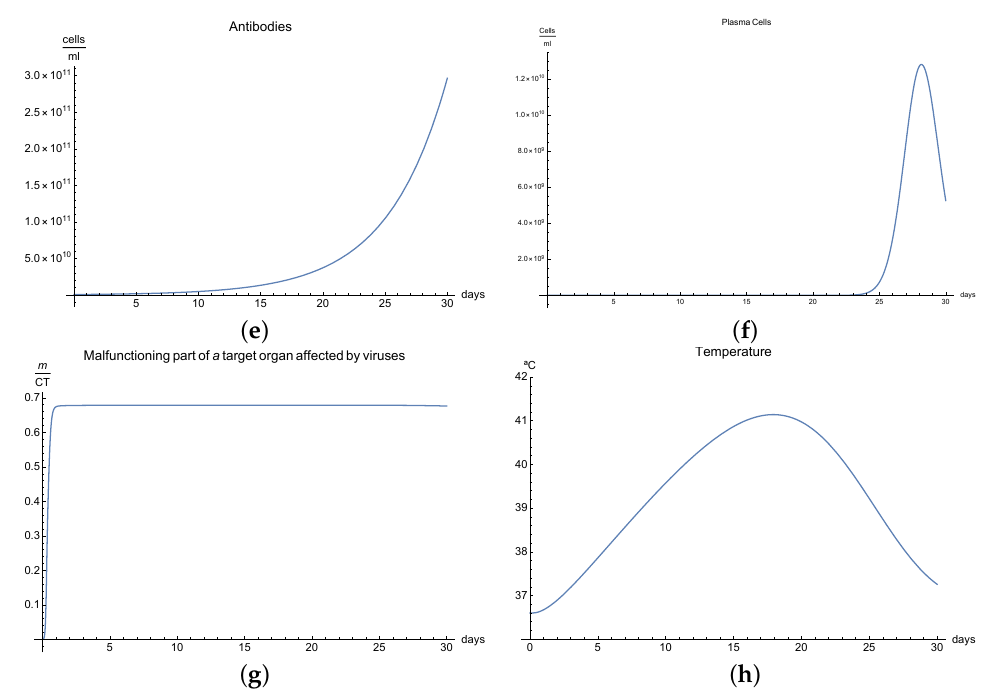
Figure 2. Numerical results of the mathematical model for the case with the immunophysiological response of COVID-19 infection in its “immunodeficient” form: ( a ) the viral load V ( t ) , ( b ) the cytotoxic T-lymphocytes T e ( t ) , ( c ) the B-lymphocytes B ( t ) , ( d ) the class 1 helper T-lymphocytes T H 1 ( t ) , ( e ) the antibodies A ( t ) , ( f ) the plasma cells P ( t ) , ( g ) the malfunctioning part of a target organ affected by viruses m ( t ) , and ( h ) body temperature θ ( t ) . In all cases, the numerical results are simulated for the “immunodeficient”